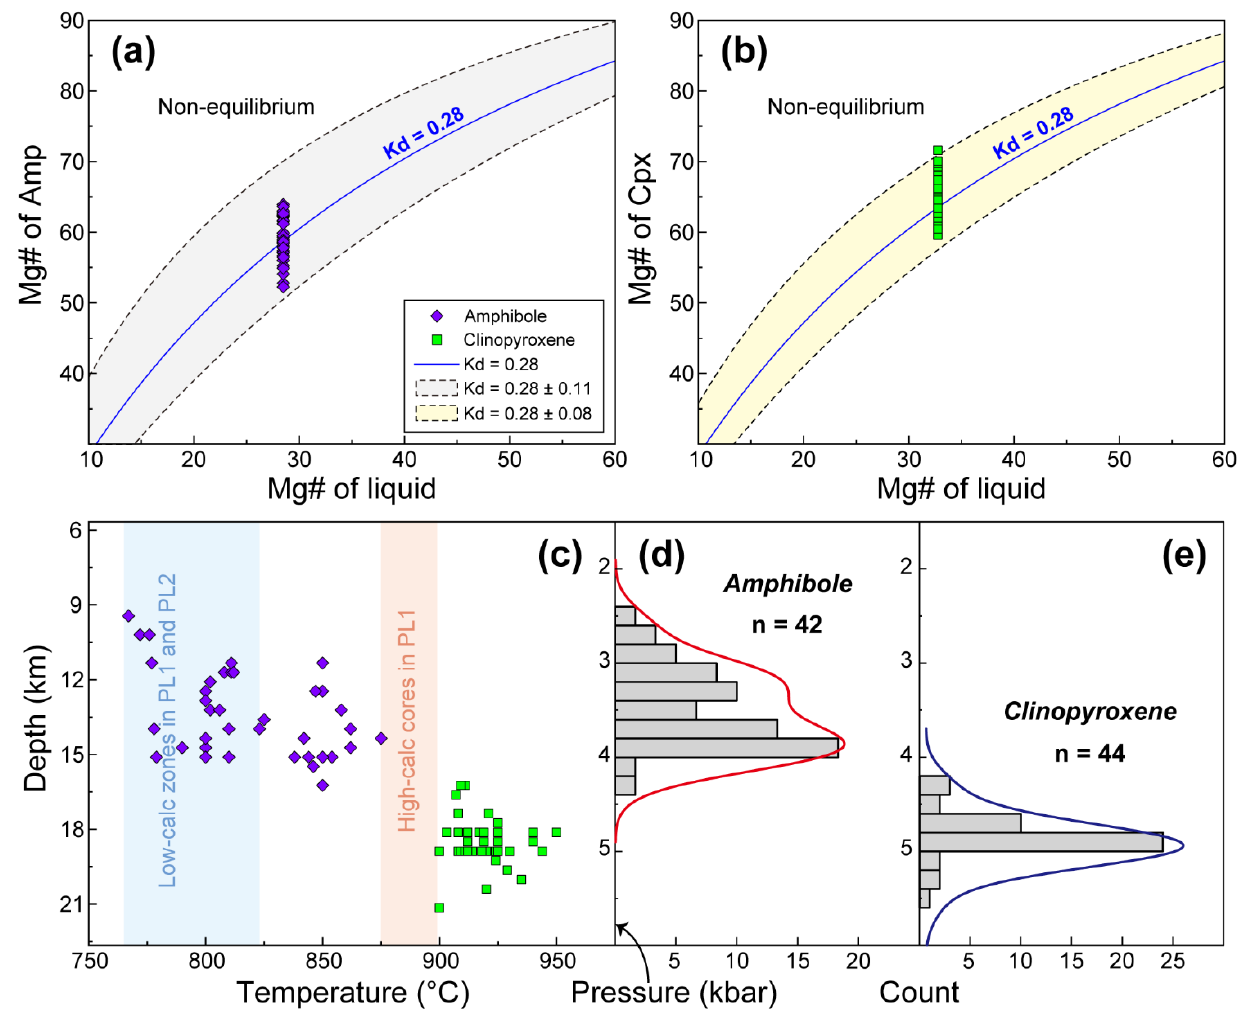
Figure 10. Rhodes diagrams for testing the Fe-Mg exchange equilibrium of amphibole ( a ) and clinopyroxene ( b ). ( c ) The estimated temperature of plagioclase, amphibole, and clinopyroxene [23]. The estimated pressure of amphibole and clinopyroxene ( d , e ). The red and blue lines are the density curves of estimated pressure.